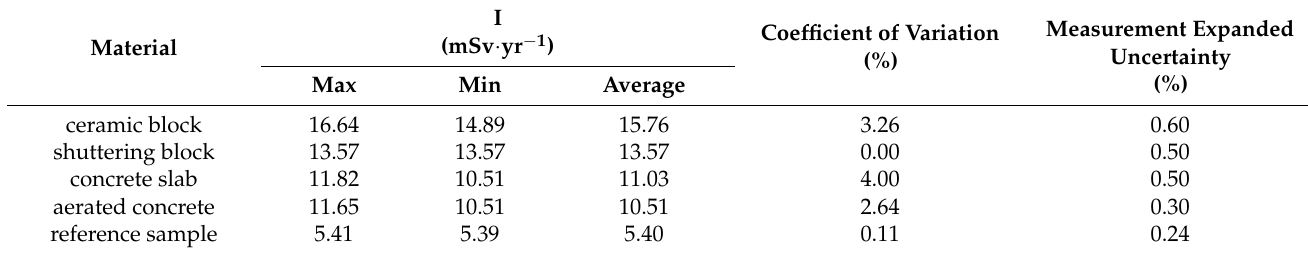
Table 3. Radioactivity concentration index measured for structures and